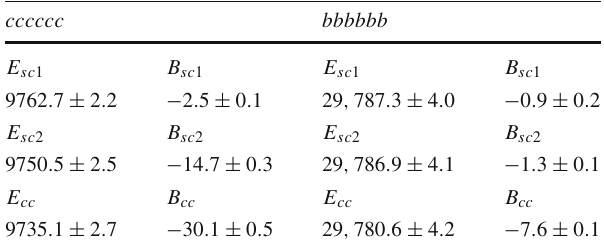
Table 4 The energies and binding energies (in MeV) of every sin- gle channel and the channel-coupling calculation of the Ω ccc Ω ccc and